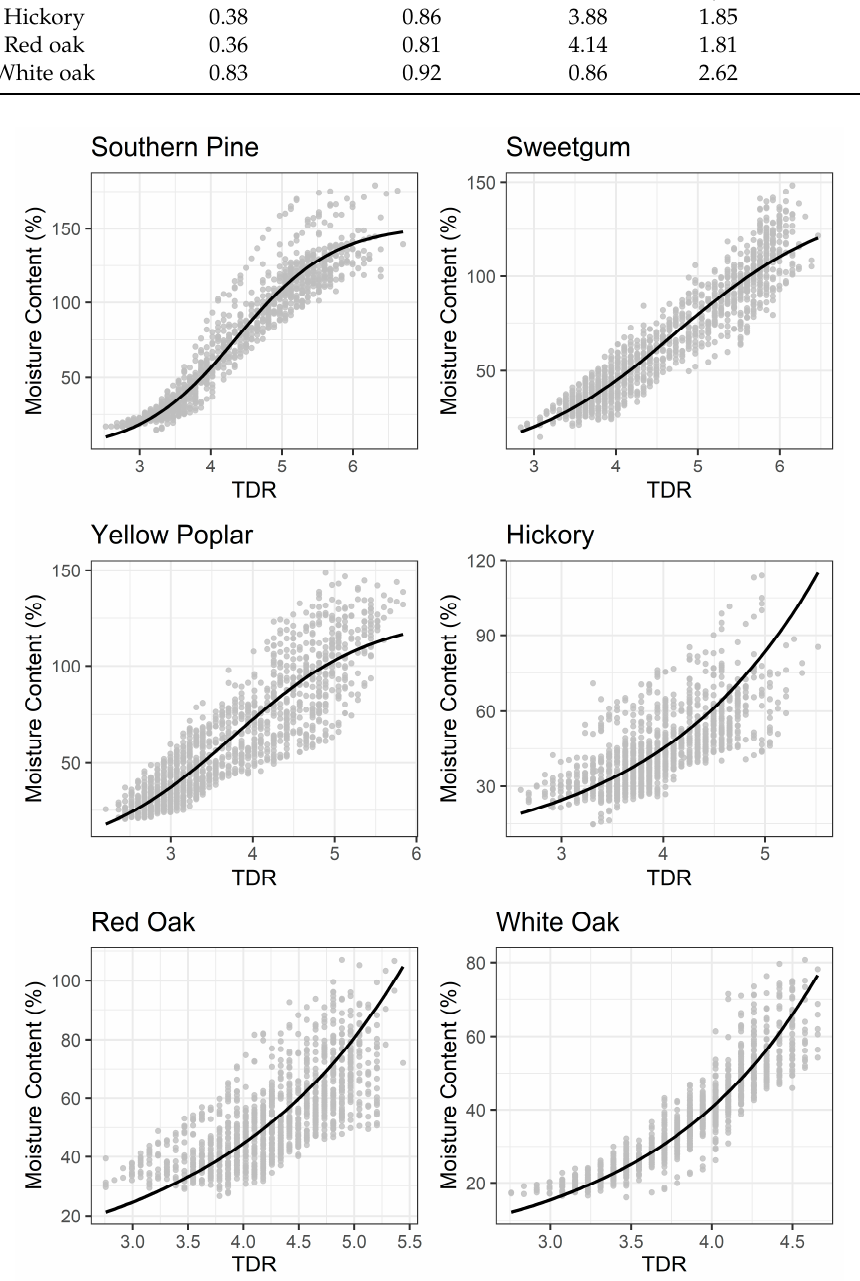
Figure 4. Moisture content vs. time-domain reflectometry (TDR) readings for each